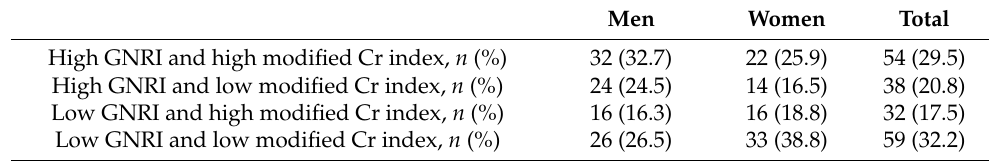
Men Women Total